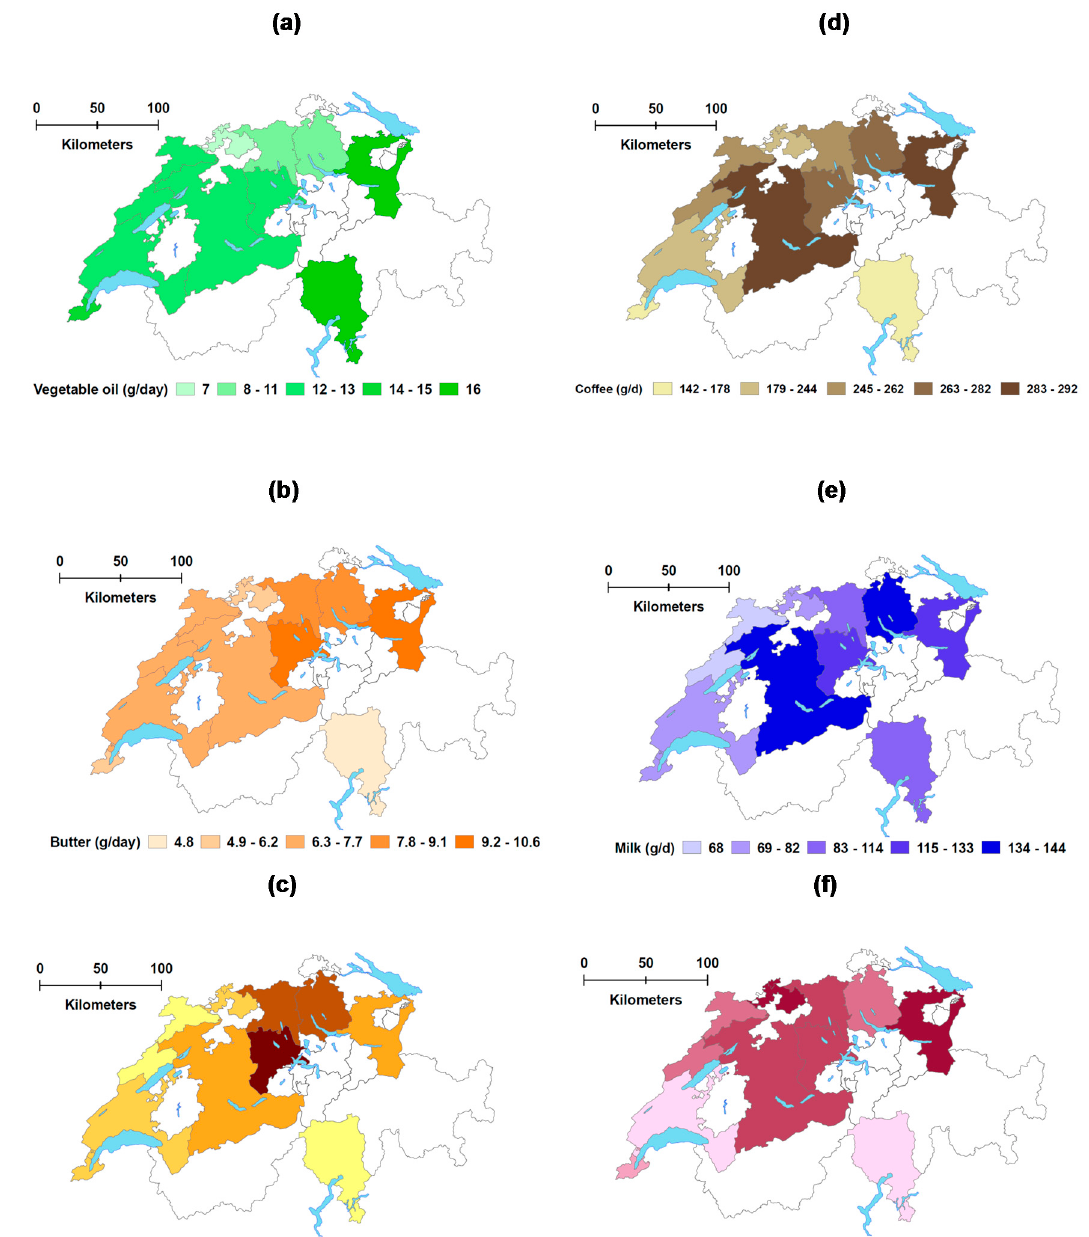
Figure 1. Daily consumption (weighted mean) of vegetable oil ( a ); butter ( b ); other fats (i.e., cream, fatty sauces and other fats) ( c ); coffee ( d ); milk ( e ); and soft drinks ( f ) for 12 cantons/states.